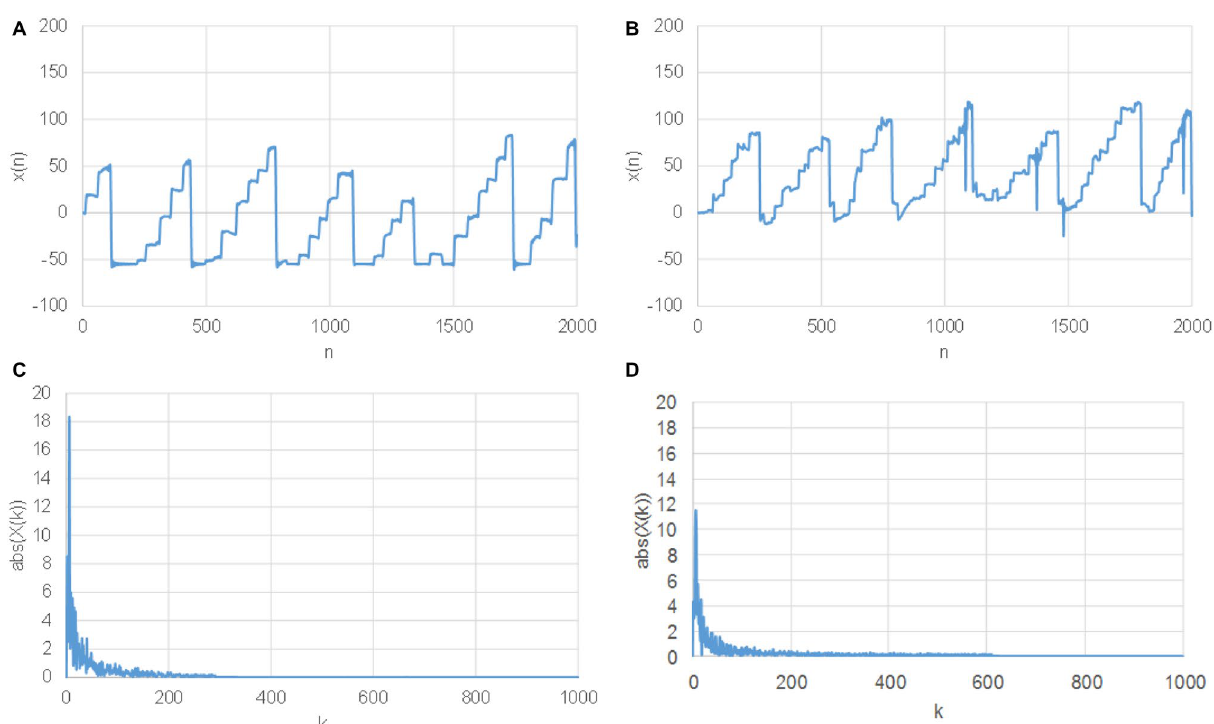
Figure 5. Time domain interpolated signal (x-axis) for a typical LR subject ( A ), and HR subject ( B ). Magnitude spectrum of time domain interpolated signal (x-axis) for a typical LR subject ( C ), and HR subject ( D